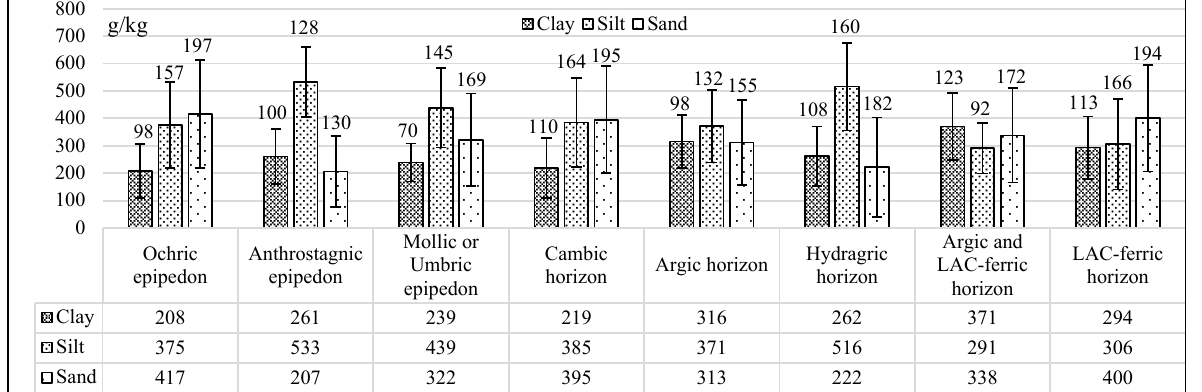
Figure 3. Mean values and standard deviation of clay, silt, and sand content of diagnostic horizons.